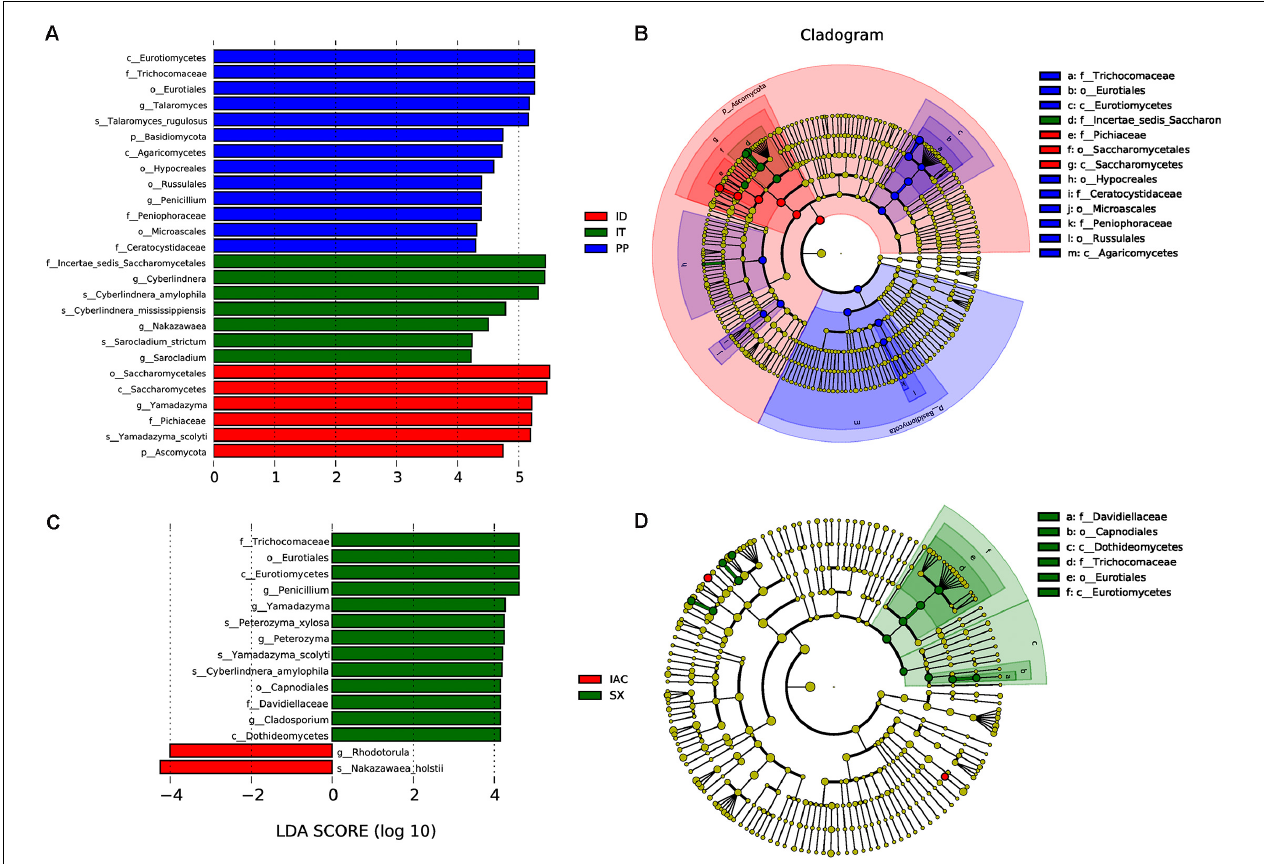
FIGURE 7 | LEfSe analysis. (A) The histogram of the Linear discriminant analysis (LDA) scores illustrating the differentially abundant fungal communities in the spruce feeding bark beetles (IT, ID, and PP). The LDA score at log 10 > 4 is set as threshold and the length of each bin, i.e., LDA score represents the extent to which the fungal biomarker differs among the groups. (B) The cladogram illustrating the presence of fungal biomarkers that are significantly different between the spruce beetles. (C) The LDA score plot (log 10 > 4 as the threshold) representing the significantly abundant gut fungal communities in the pine feeding beetles (IAC and SX). (D) The cladogram describing the fungal biomarkers in pine beetles. The circles representing from inside to outside denotes different taxonomic level (phylum to genus). Each circle resembles a distinct taxon at the respective taxonomic level. The relative abundance of a particular taxon is proportional to the size of that circle. The color of the fungal biomarkers is according to the color of corresponding bark beetle while yellowish-green dots designate the non-significant fungal species. Red and green nodes denote that these fungi contribute highly to the group. Letters above the circles denote the fungal